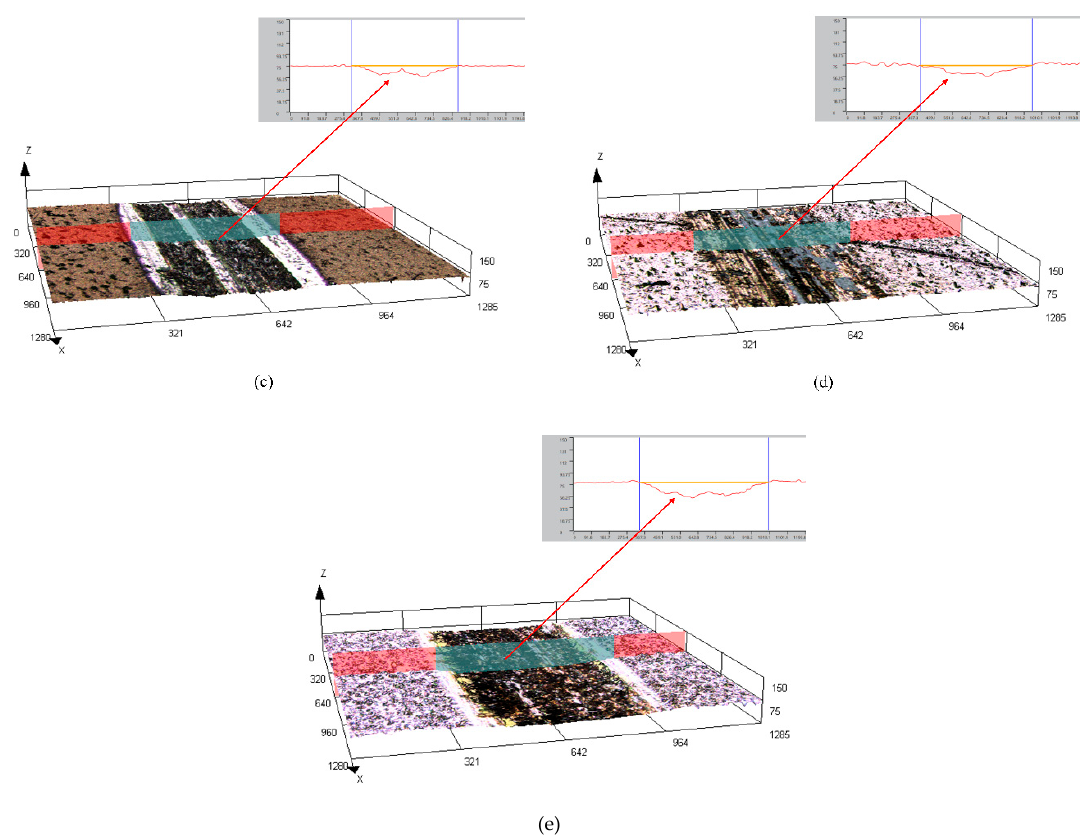
Figure 9. Effects of SiC particle concentration on the wear mark morphology of coatings. ( a ) 2 g/L; ( b ) 4 g/L; ( c ) 6 g/L; ( d ) 8 g/L; ( e ) 12 g/L. Table 7. Effect of SiC particle concentration on wear mark section parameter of coatings.